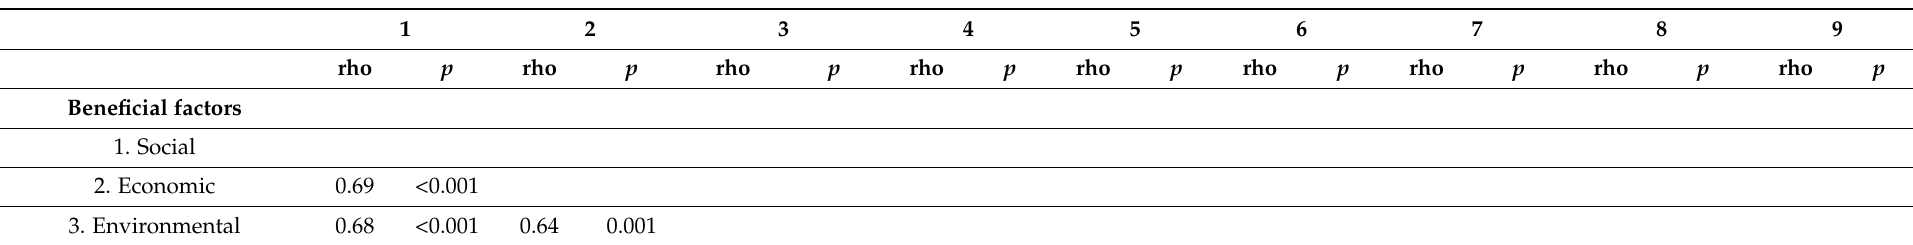
Table A6. Correlation analysis with Spearman’s rho coefficient. Source: Own